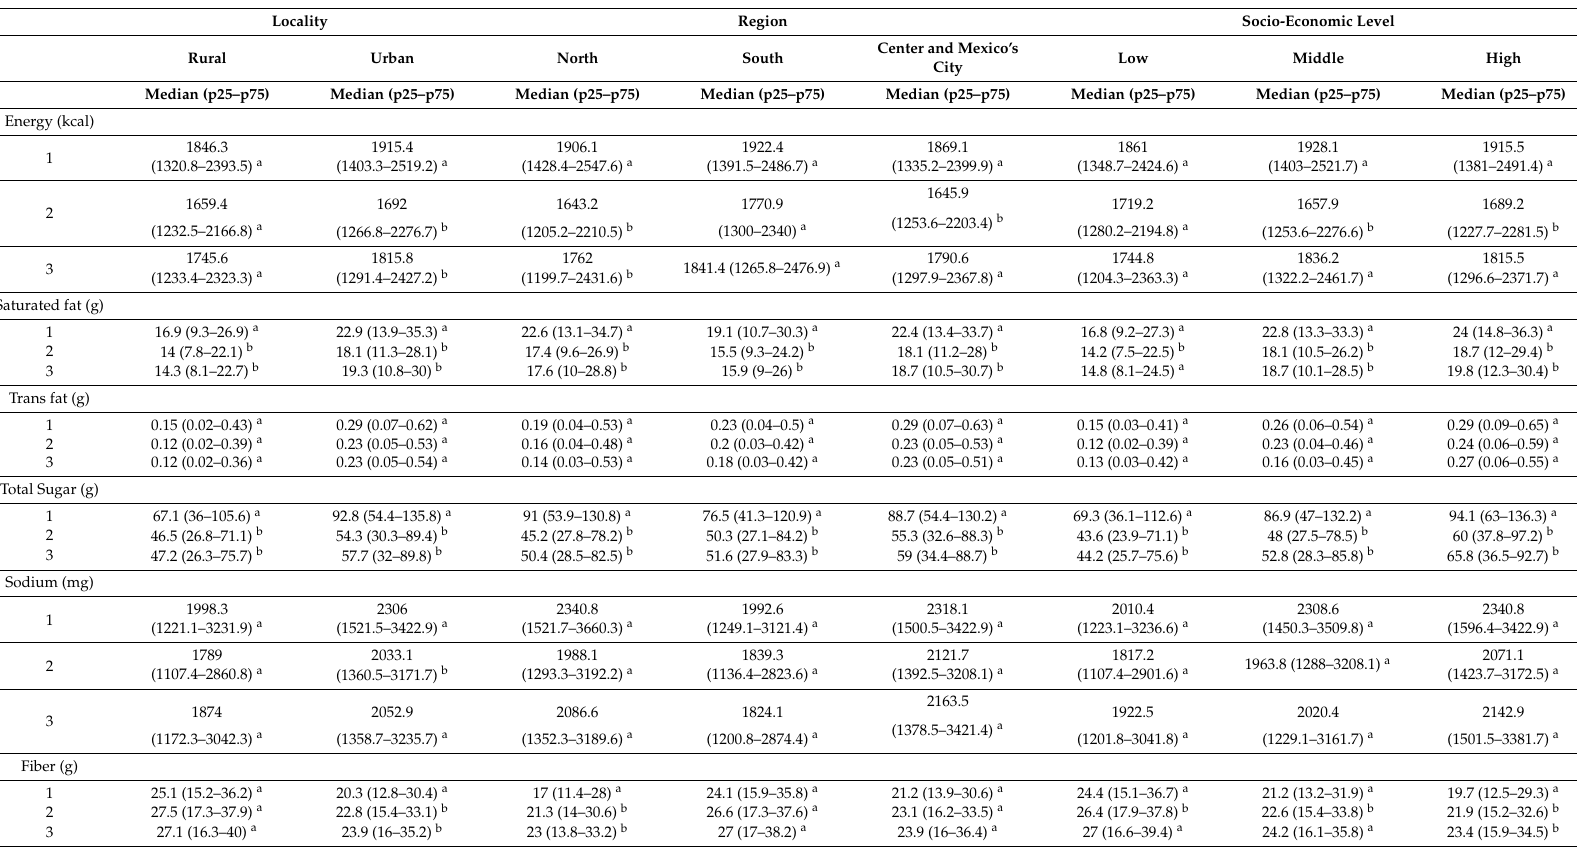
Table A4. Energy and nutrient intake by locality, country region and socio-economic level before and after food replacement in the diet of the Mexican adult population + . Mexico, ENSANUT